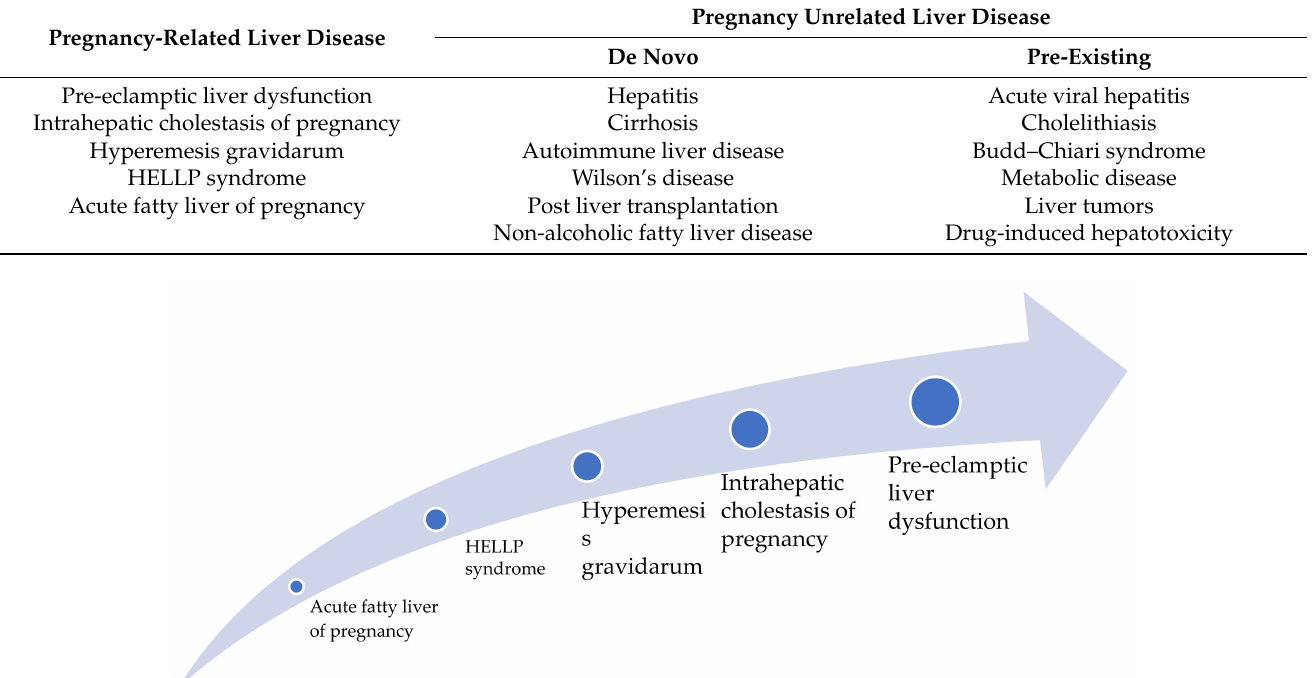
Table 1. Pregnancy-related and unrelated liver disease. Data from Ref [7].